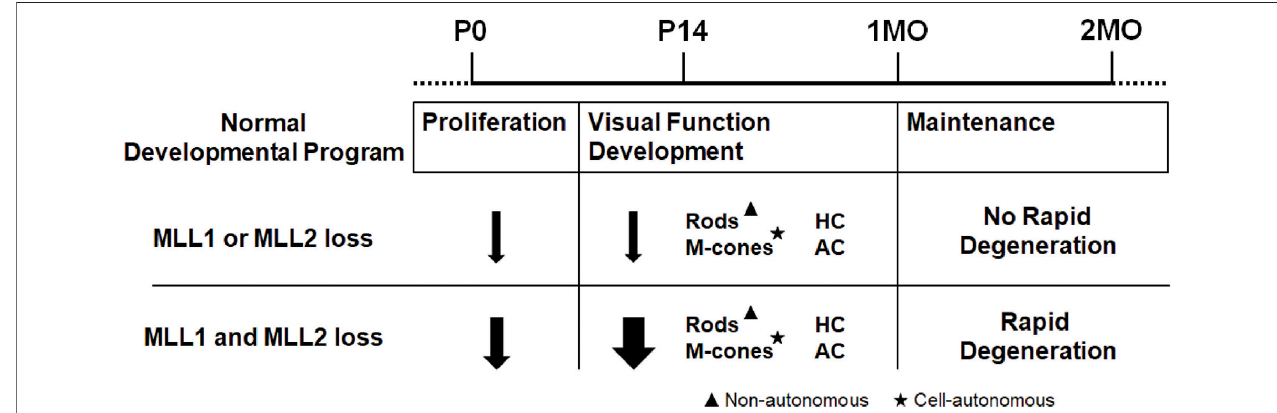
FIGURE 8 | Summary of retinal defects in Mll1 and Mll2 conditional